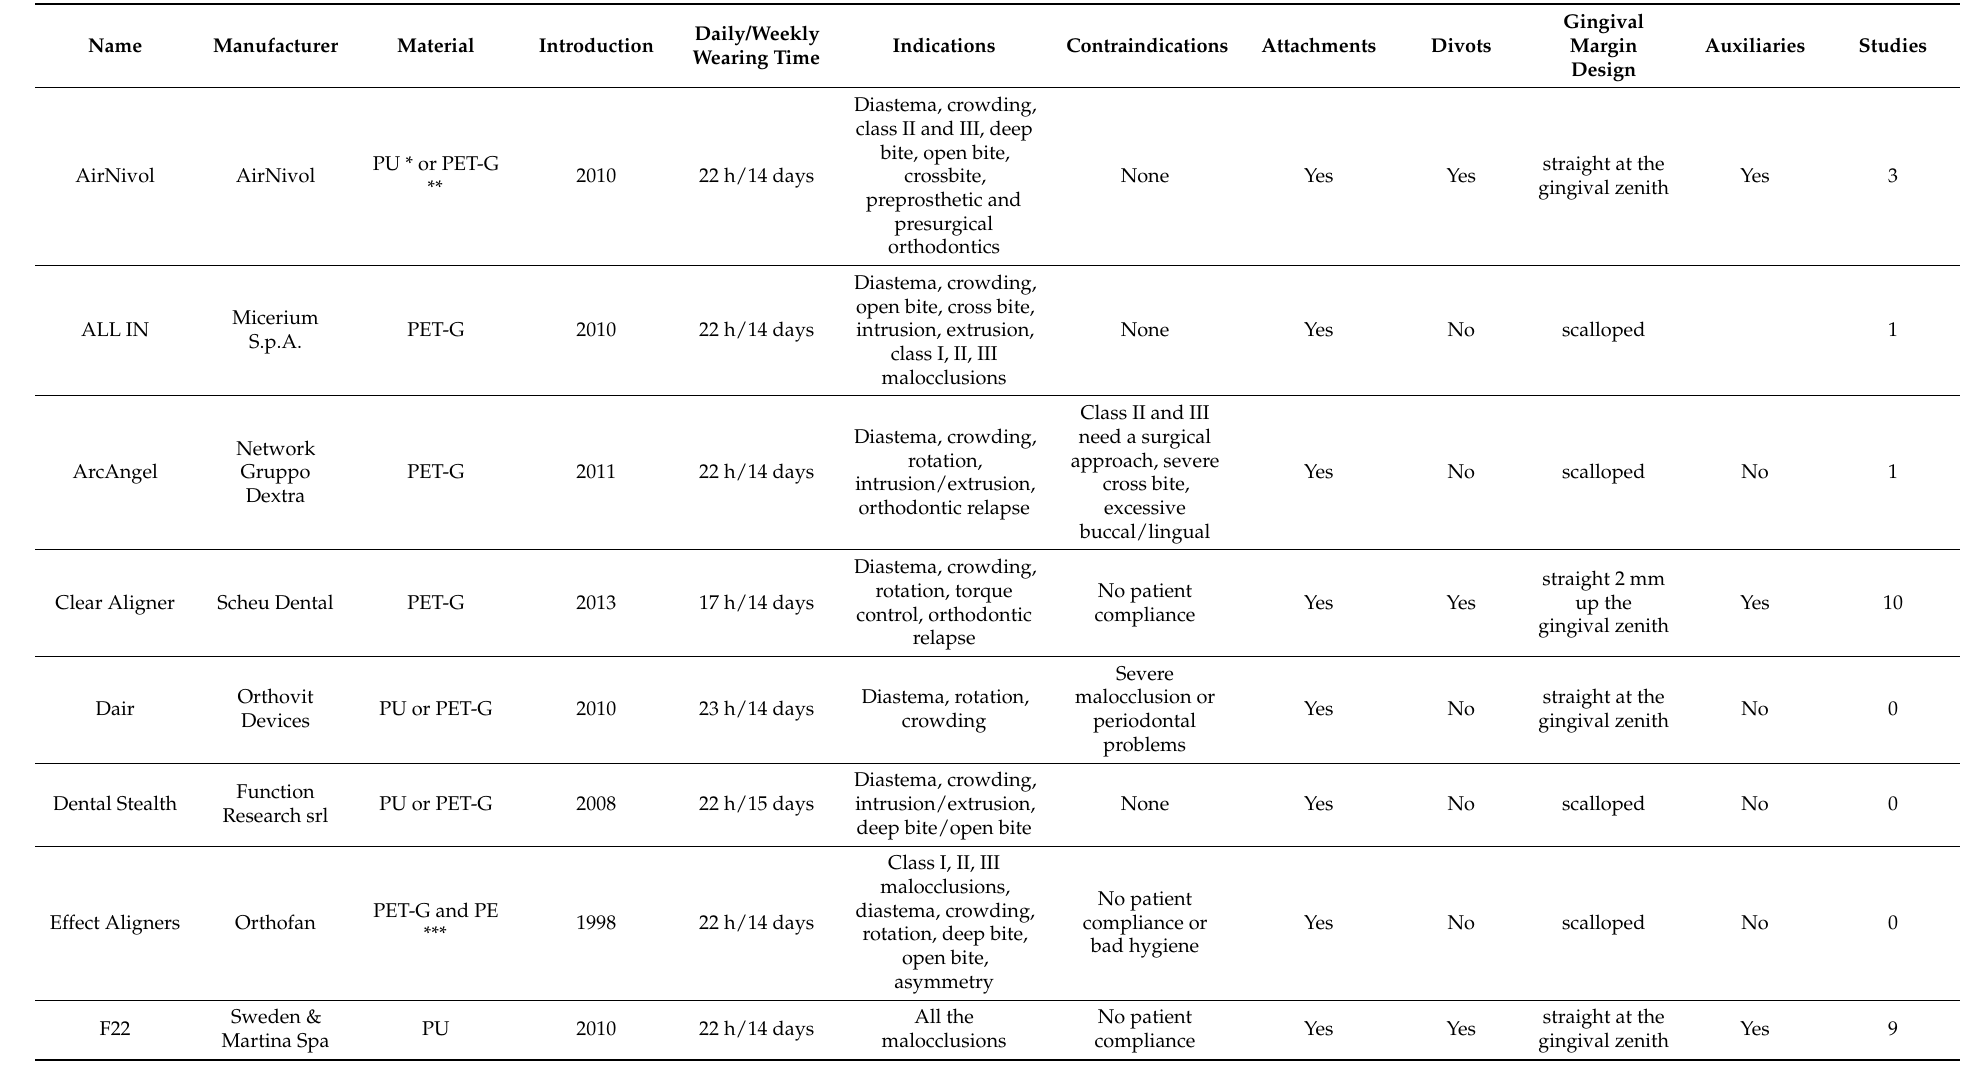
Table 1. Brands of clear aligners currently used in Italy with the main basic information and number of scientific studies in which they are